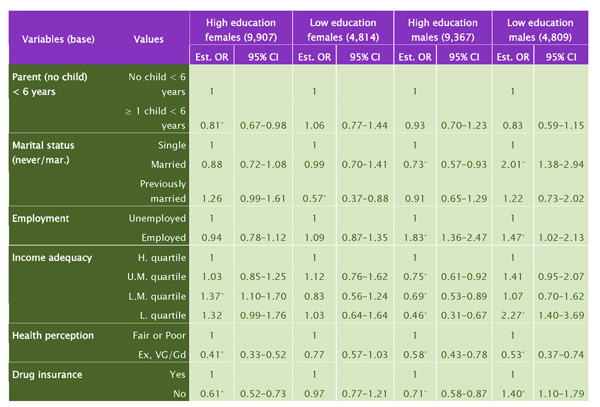
Association Between Selected Medication (Rx) Use and Selected Social and Health Factors: Results of Logistic Regression Analysis Source: NPHS 1996–1997 health share data (based on 2 day detailed data – Rx medication use).This sample accounts for approximately 7500 records in which the two-day detailed drug data was not coded.  "Drugs based on the ATC codes, for Stomach problems, laxatives, pain/analgesics, coughs and colds, allergies, diabetes (insulin and oral   hypo-glycaemics), cardiac conditions, hypertension (including diuretics), antibiotics, thyroid,   asthma were categorized as prescription or OTC."